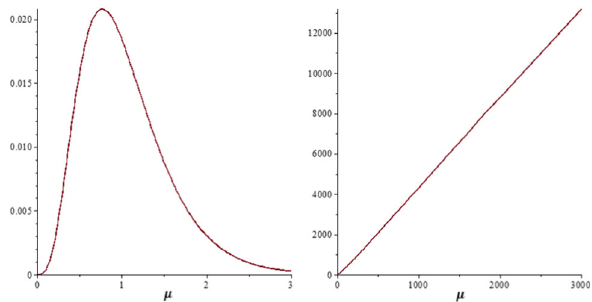
Fig. 2 The effect of removing the logarithmic singularities from p.v.t.s of the pair creation (+) and σ (cid:9) = σ (left panel) and lepton creation ( − ) and σ (cid:9) = − σ (right